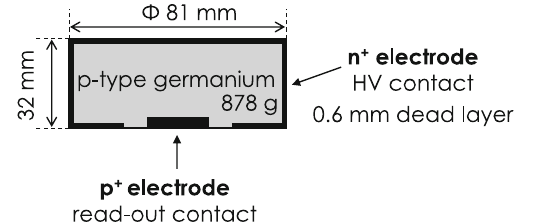
Fig. 7 Schematic drawing of the bare BEGe detector used in the study [23]